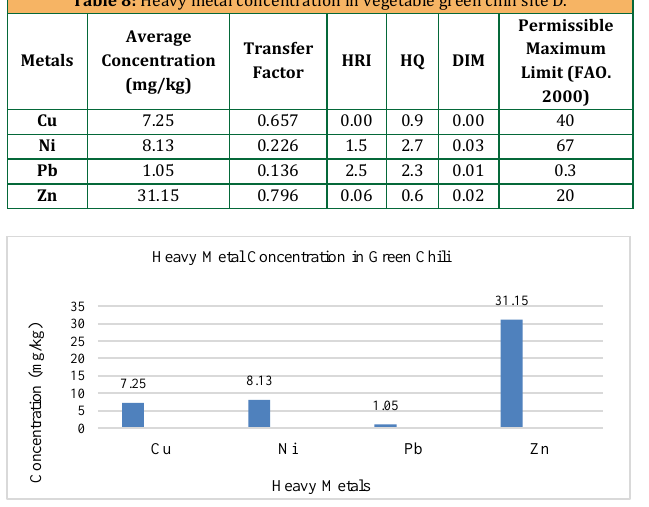
Table 8: Heavy metal concentration in vegetable green chili site D.